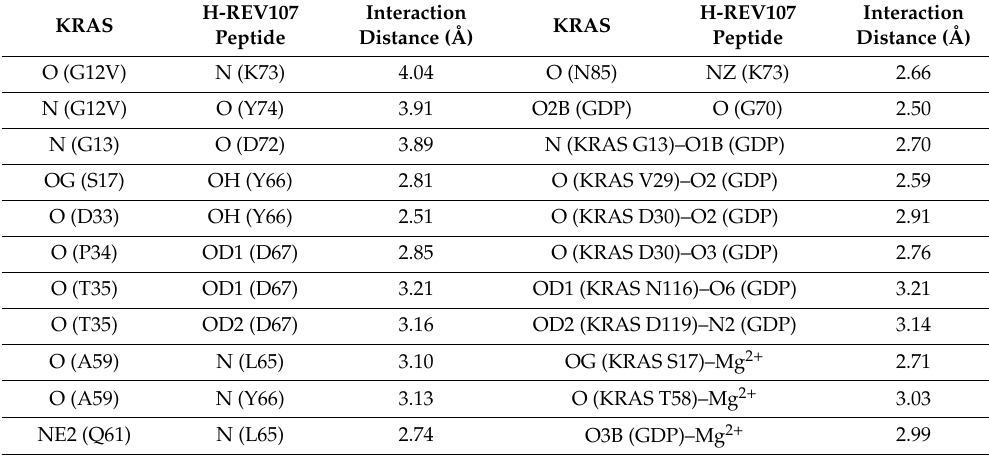
Table 2. Interaction distances between KRAS G12V and H-REV107